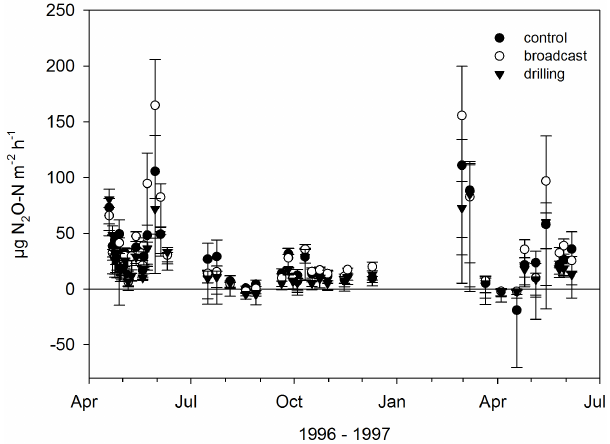
Fig. 2. N 2 O emission at Mellby, comparing fertiliser spreading techniques; site had one control plot without N-additions. Average emission and standard error of eight static chambers per treatment.